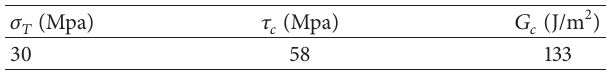
Table 2: Dynamic strength parameters of PMMA.